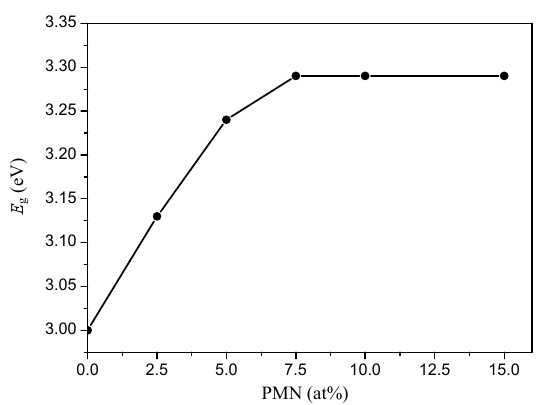
Fig. 5 Band gap E estimated from the plots of the g modified Kubelka–Munk function versus composition of the samples. The solid curve has been drawn to guide the